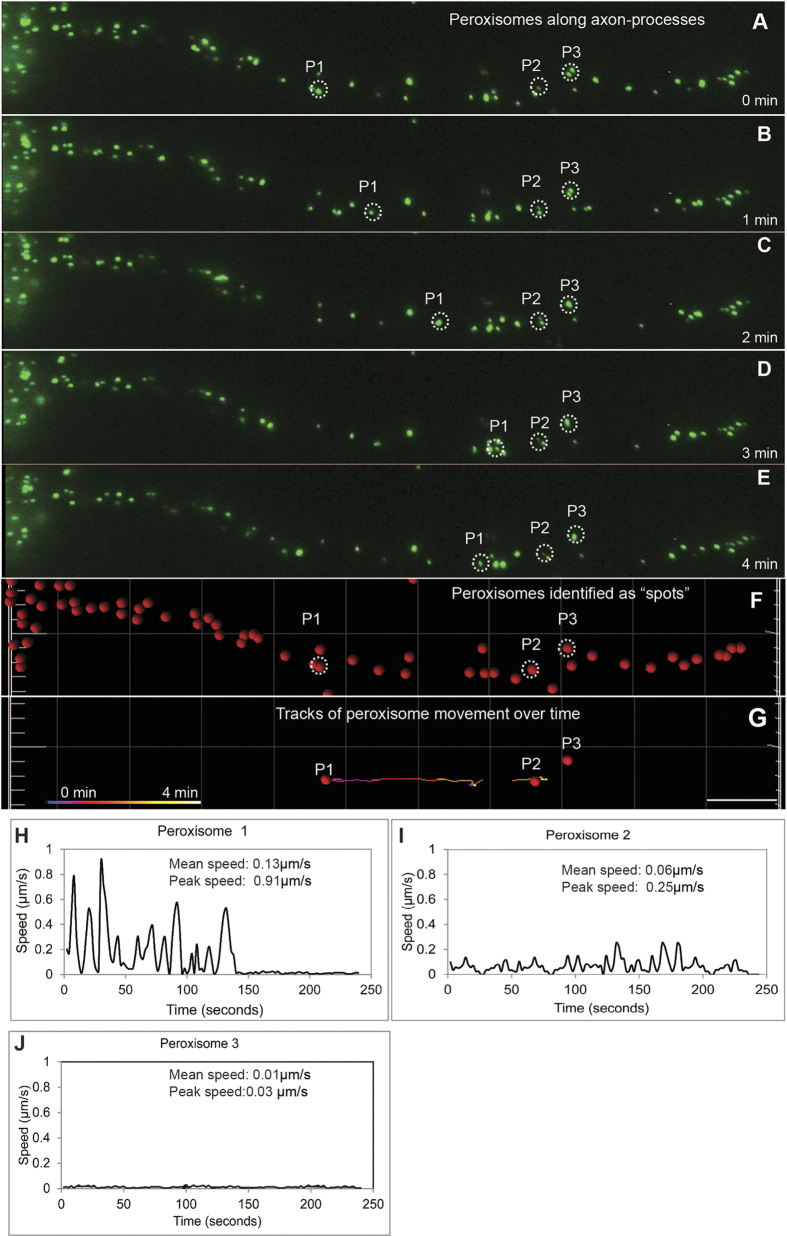
Automated analysis of peroxisome movement along axon-like processes.(A–E) Images from a time-lapse movie of a control axon-like process at the times indicated. GFP-labelled peroxisomes are evident (green dots). Three example peroxisomes (P1-P3, circled) indicate peroxisomes moving different distances during the four minutes. (F) The computer-generated representation of the peroxisomes in the image shown in A (red dots). (G) The computer-generated tracks of movement of P1-P3 assessed from successive 2 second images over the 4 minute observation period. Scale bar in (G) applies to (A–G) 10 μm. (H–J) The speed of peroxisome movement was plotted against time for the three identified peroxisomes. At this time scale, peroxisome movement was characterised by saltatory movement with bursts of movement separated by rest periods. The fastest moving peroxisomes were characterised by multiple fast saltatory movements with rest periods, as for peroxisome P1. The majority of peroxisomes moved either like peroxisome P2, with multiple slow saltatory movements characterised as Brownian-like motion, or were immobile like peroxisome P3.